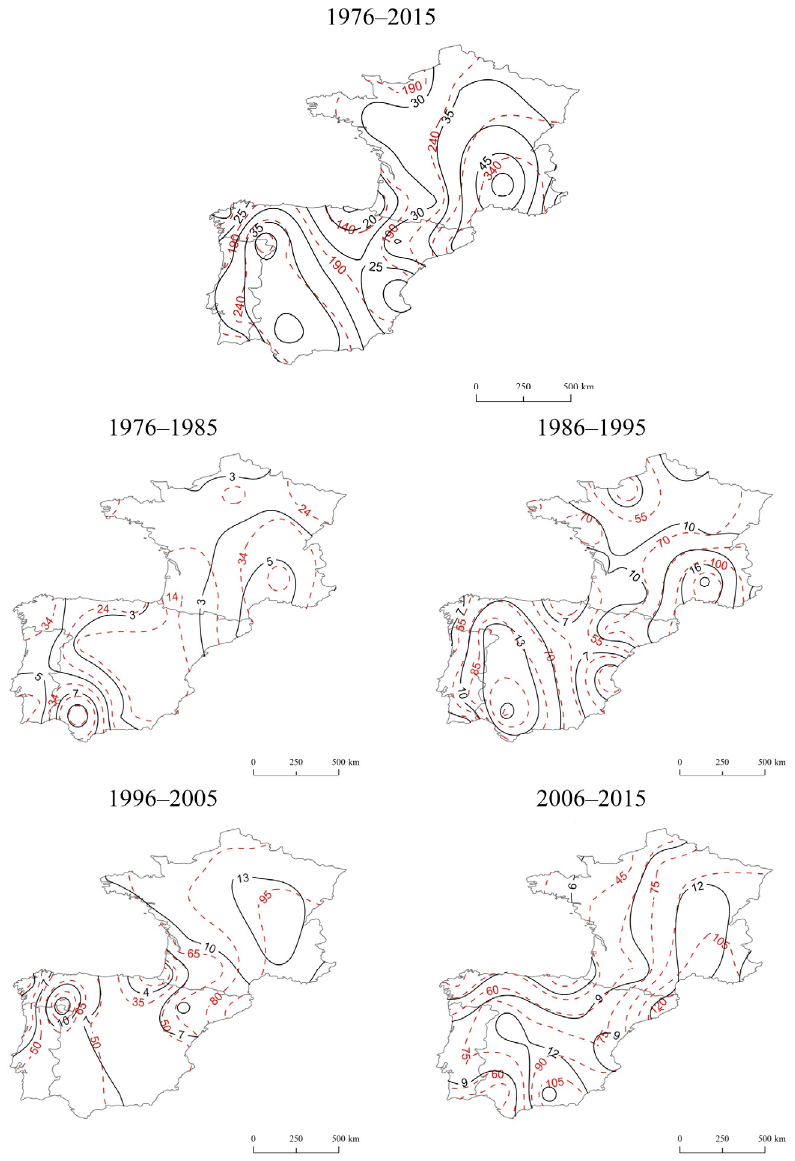
Figure 4. Spatial pattern of the total number of HWs (black solid lines) and the total duration of HWs (red dashed lines) in 1976–2015.